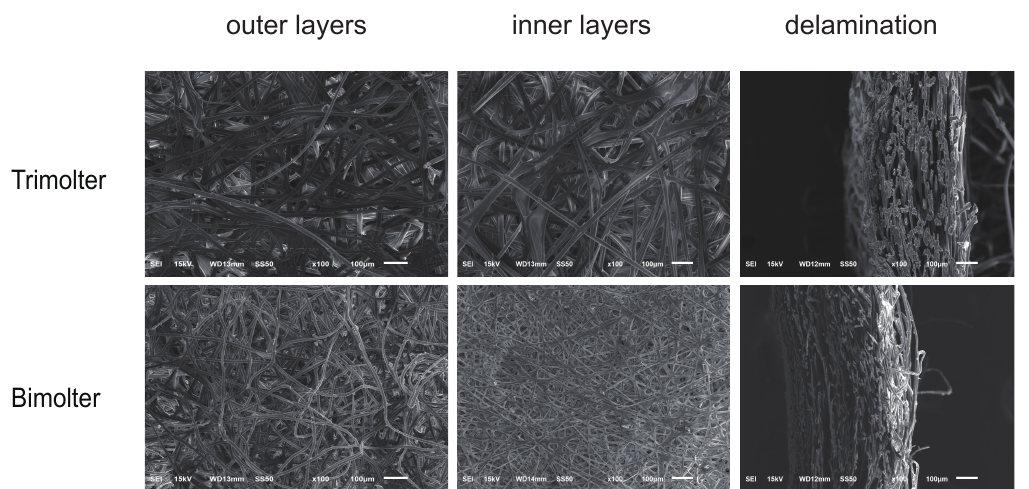
Figure 3. SEM micrographs of the outer layers, inner layers and delamination of cocoons obtained from bimolter treatment groups and trimolter control groups. Bars represent 100 µ m.